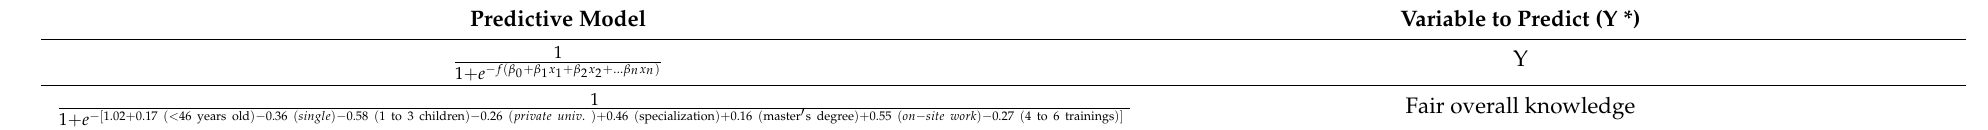
Table 5. Construction of a predictive model for fair overall knowledge of DIRIS Lima Norte dentists about COVID-19. Predictive